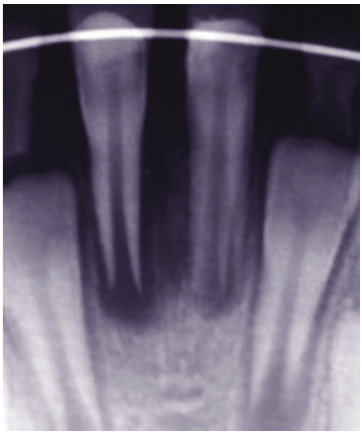
Figure 6: Three-month follow-up radiograph.